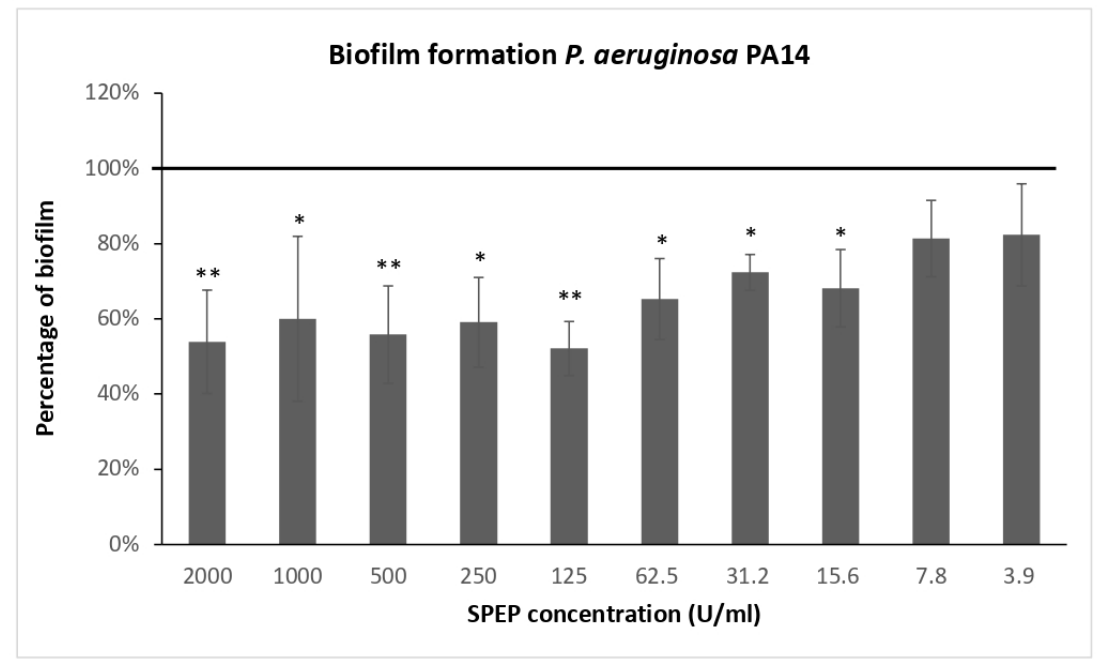
Figure 1. SPEP effect on P. aeruginosa PA14 biofilm formation starting from a concentration of 2000 U/mL. Results are expressed as the percentage of residual biofilm formation compared with an untreated sample. Data reported are representative of three independent experiments. Error bars indicate the standard deviations of three measurements. Statistical differences were determined by the Student’s t -test: * p < 0.05; ** p < 0.01, compared with the untreated samples.